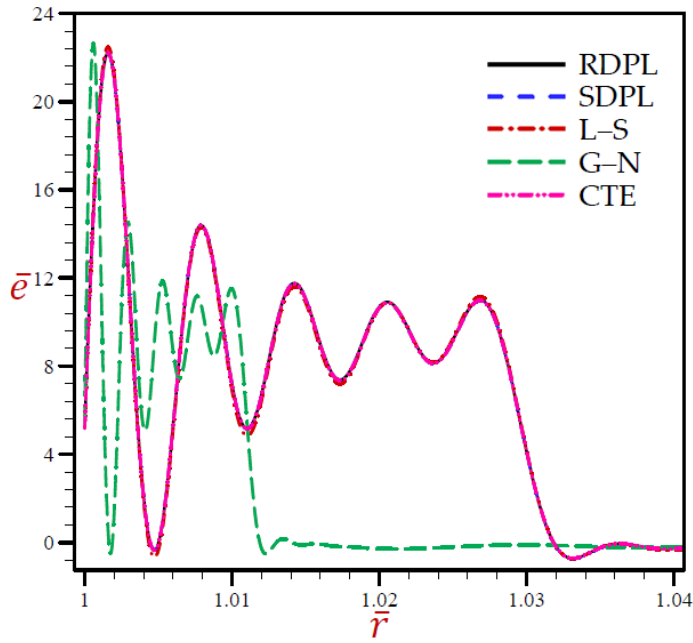
Figure 3. The volumetric strain 𝑒̅ through radial direction of a spherical hole presenting to all mod- els.